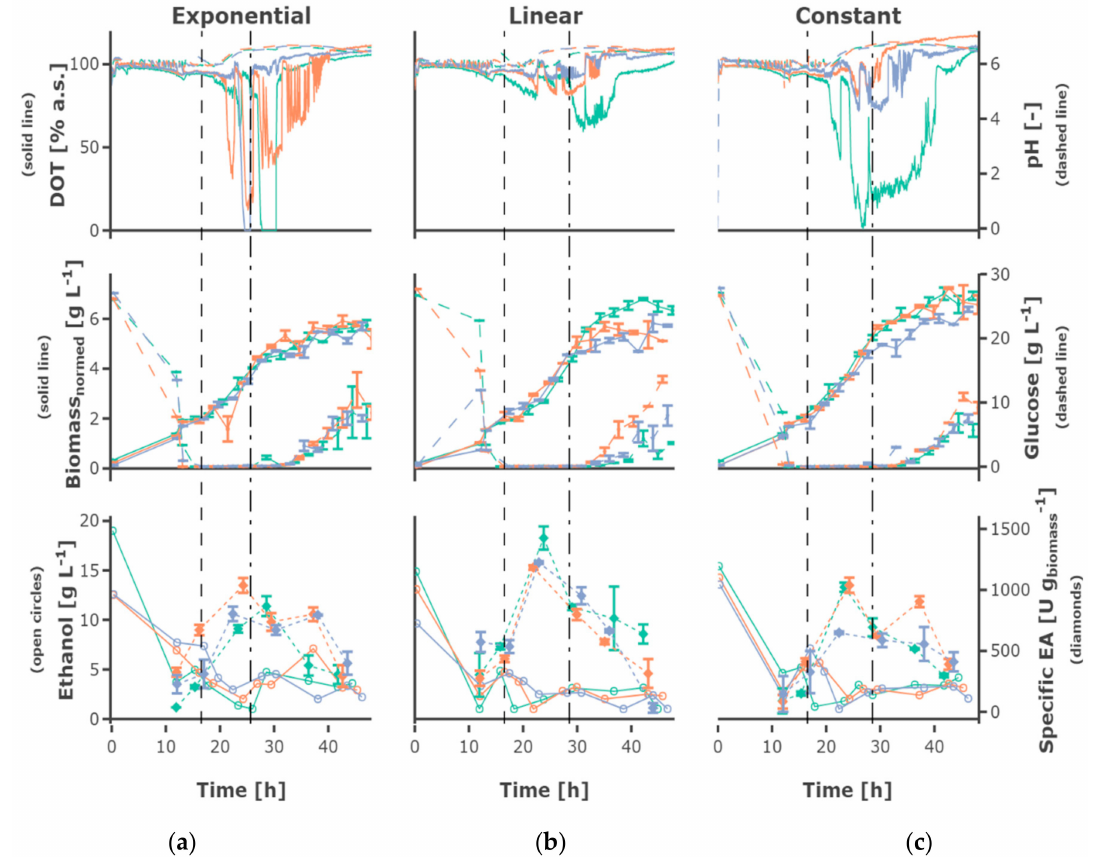
Figure 5. Cultivation data regarding growth at different feed profiles applying a feed rate of 0.175 h − 1 . Measurement data is shown regarding the designs 2, 4 and 9—( a ) exponential, ( b ) linear and ( c ) constant feed at a feed rate of 0.175 h − 1 with an initial substrate concentration S 0 = 30 g L − 1 and no hunger phase. The DOT and pH, biomass and glucose concentration as well as ethanol concentration and specific enzyme activity are shown. The mean and standard deviation are shown regarding duplicate measurements for biomass and glucose concentration and regarding triplicate measurements for specific enzyme activity. The three MBR cultivations performed under the same conditions are shown in different colors, the start of the feed and the constant fed-batch phase are shown by the vertical dashed, respectively dashed-dotted line. Interactive versions of the plots can be found online